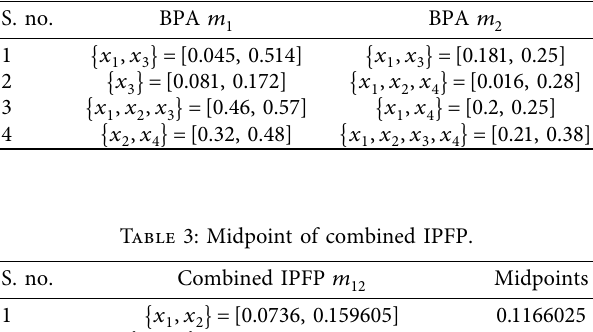
Table 2: Basic probability assignments by two experts.